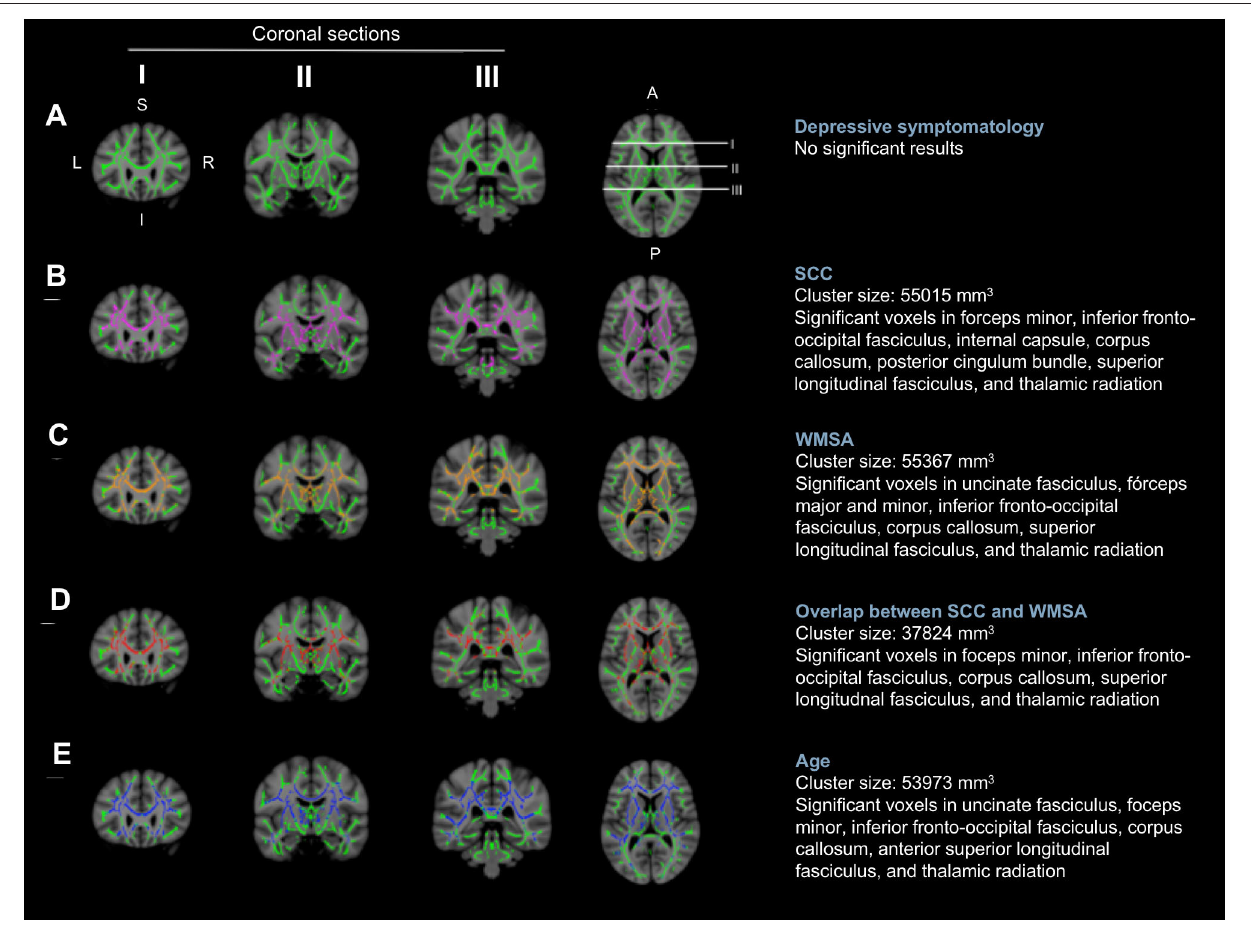
FIGURE 3 | Voxel-wise correlations of MD values with depressive symptomatology, SCC, WMSA, and age. The white matter skeleton is depicted in green. Significant voxels are colored in pink [ (B) the association between MD values and SCC], orange [ (C) the association between MD values and WMSA], red [ (D) overlap of the association between MD values and SCC, and MD values and WMSA], and blue [ (E) the association between MD values and age]. No significant voxels were obtained for the association between MD values and depressive symptomatology (A) . L, left; R, right; S, superior; I, inferior; A, anterior; P, posterior; MD, mean diffusivity; SCC, subjective cognitive complaints; WMSA, white matter signal abnormalities; mm,